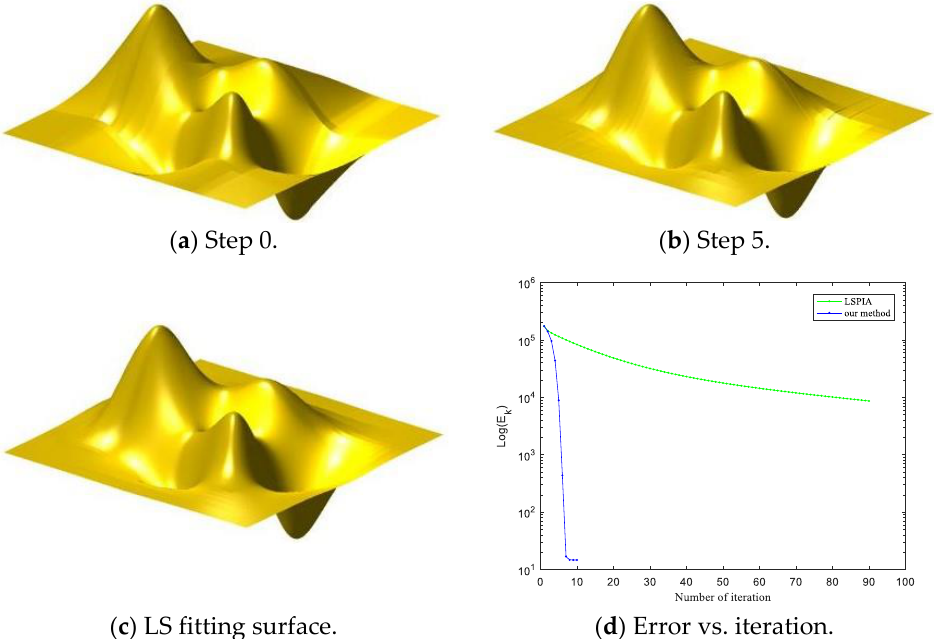
Figure 6. A data point grid with 501 × 501 points was fitted by a bi − cubic tensor product B − spline surface with 250 × 250 control points.